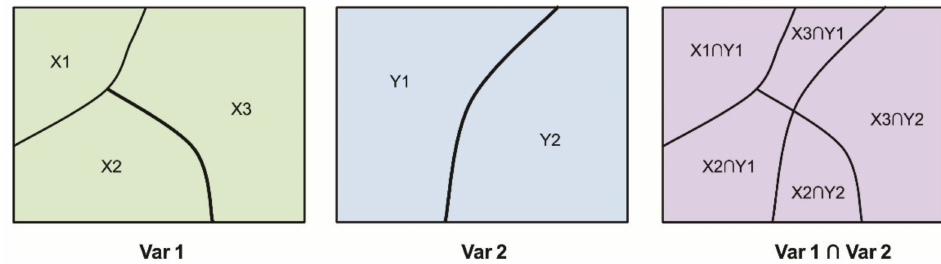
Figure 3. Principle of interactive